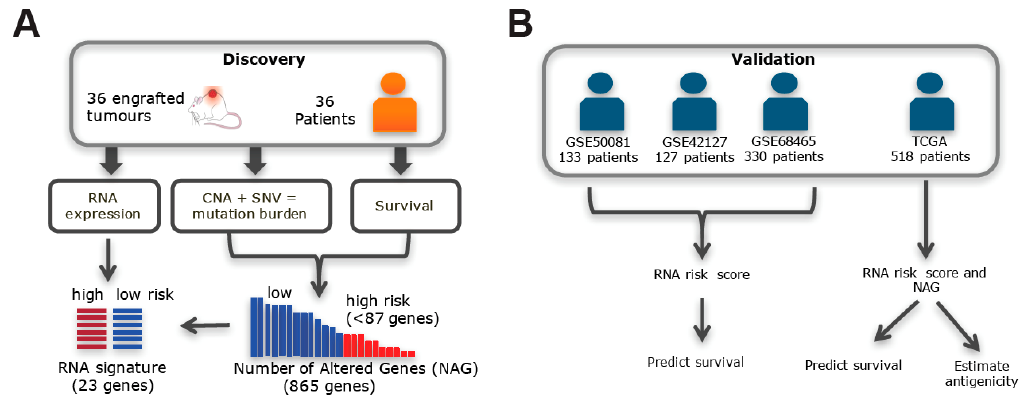
Figure 1. Translation of genomic information from patient-derived xenografts (PDXs) to predict patient outcome. ( A ) Somatic copy number aberrations (CNA), single nucleotide variants (SNV) and gene expression (RNA) were profiled in PDXs. The number of alterations within 865 genes (NAG) and the associated 23 genes’ expression signature were selected using the survival of patients corresponding to the PDXs. ( B ) The expression signature was used to calculate a risk score and predict overall survival (OS) in three independent cohorts of NSCLC patients with data accessioned in the Gene Expression Omnibus web-based data repository (GSE50081, GSE42127 and GSE68465). Survival prediction was also tested for 518 NSCLC stage I patients from The Cancer Genome Atlas (TCGA), by using both the expression signature and NAG. The mutations found in the 865 gene panel of the TCGA samples were also assessed for antigenicity.